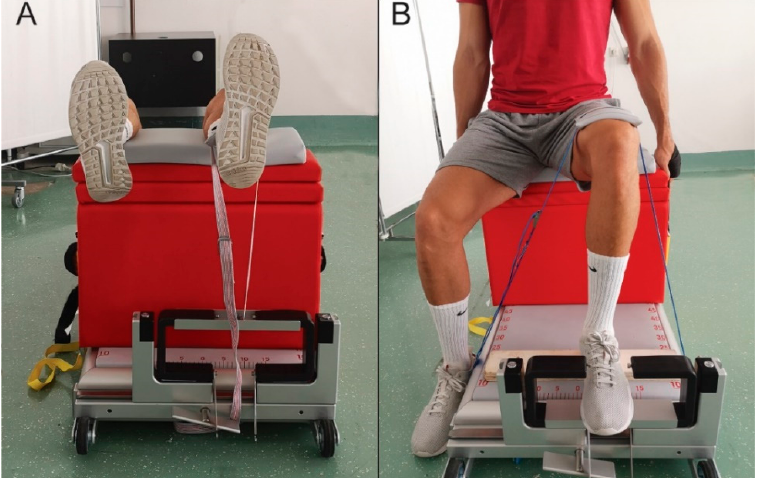
Figure 3. Knee extension ( A ) and ankle plantarflexion ( B ) strength measurements using MuscleBoard ® . Knee extension isometric strength was measured using non-elastic strap that connected participant’s lower leg with a rigid rod mounted on both sensor braces on the superior part. Ankle plantarflexion isometric strength was measured using a rigid rod that was mounted on both sensor braces on the inferior part. For both tests, sum of forces from both load cells presented one unilateral measurement.